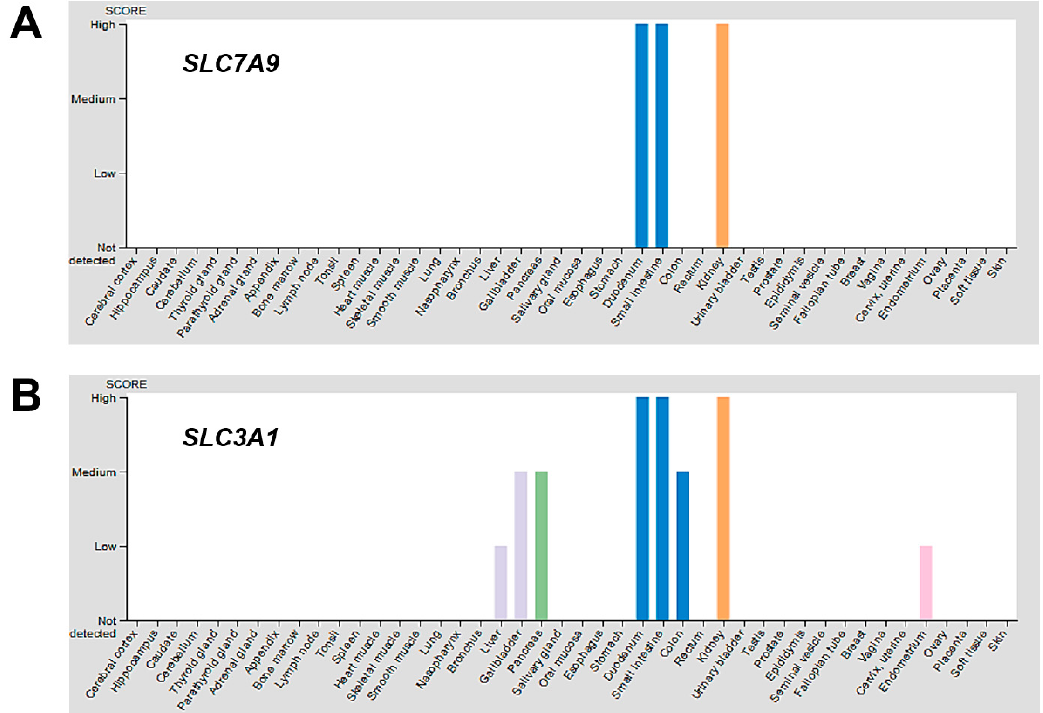
Figure 3. Protein expression overview of known CySS transporters in various tissues. Using the Human Protein Atlas [59], the protein expression overview of CySS transporters b 0,+ AT and rBAT, encoded by the SLC7A9 ( A ) and SLC3A1 ( B ) genes, respectively, were visualized. The kidneys (orange bar) represent one of the tissues with the highest expression of SLC7A9 and SLC3A1 . The skin, liver, lung, muscles, thyroid and other tissues minimally or do not express the same transporters. Only CySS transporter genes with available protein data for which a knowledge-based annotation gave conclusive results were included.